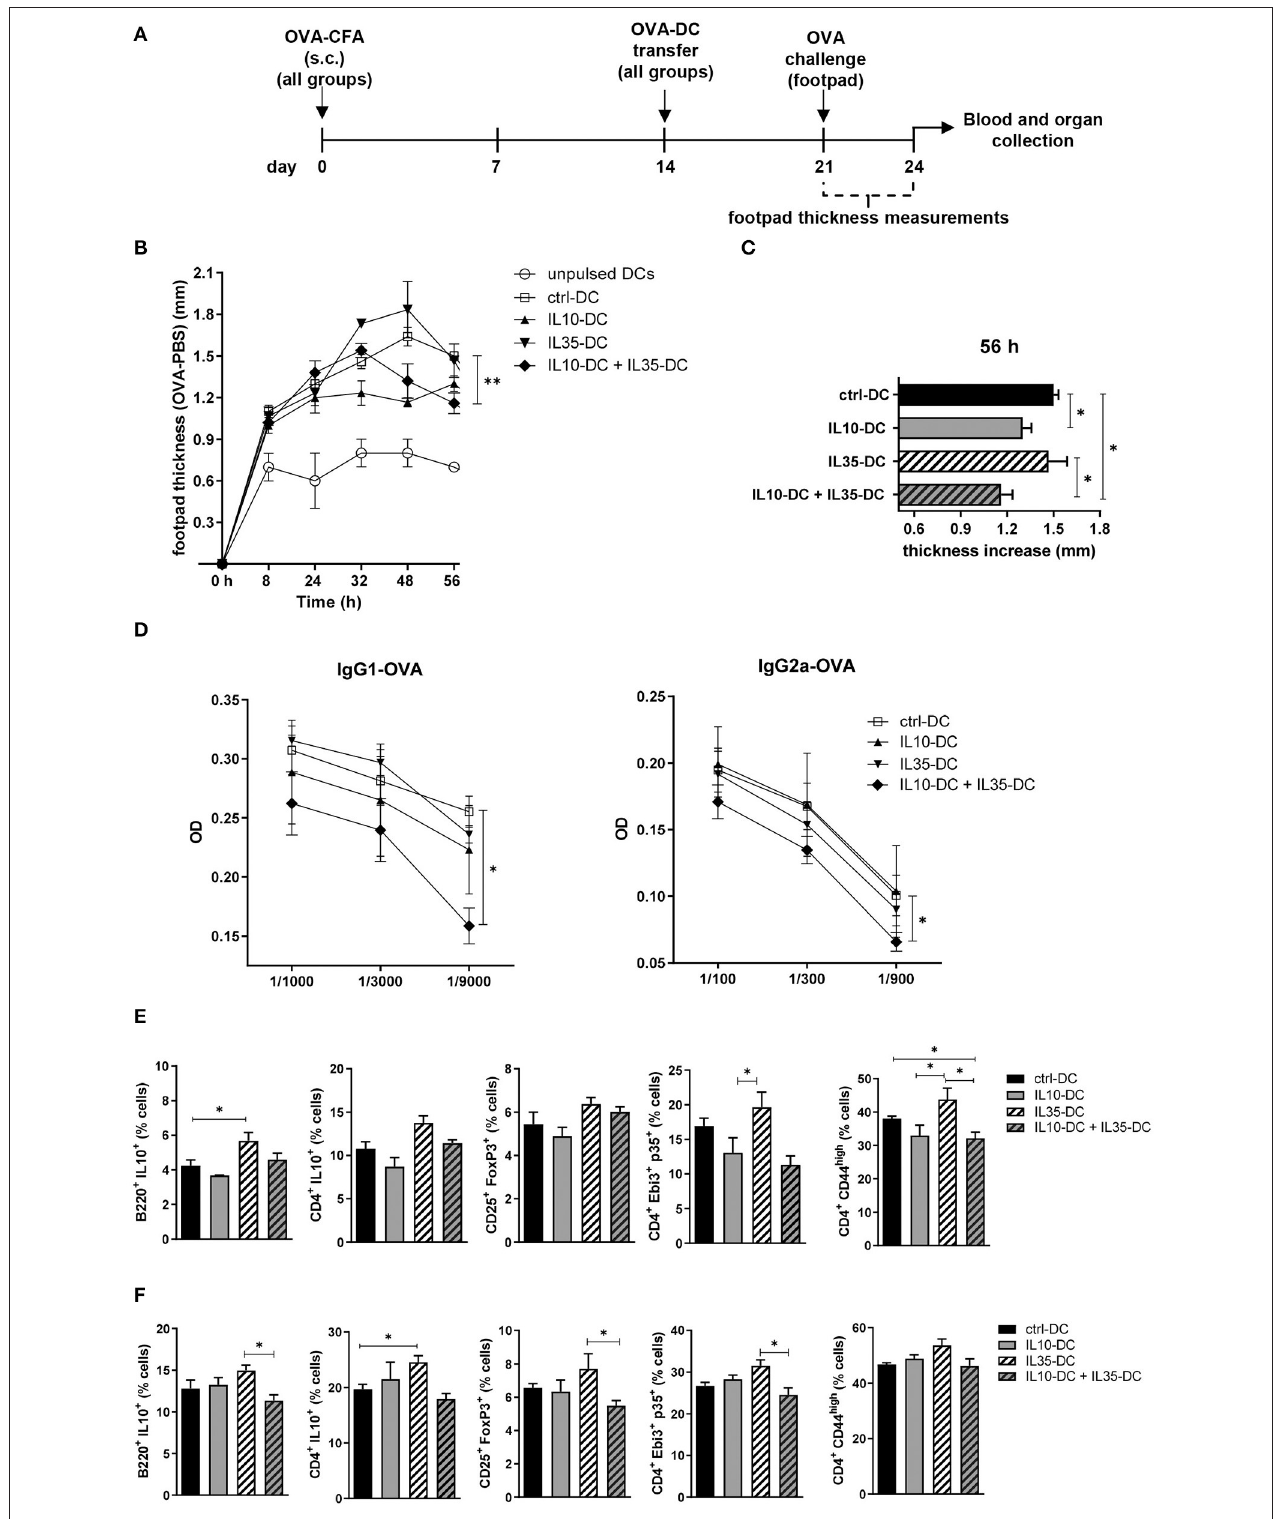
FIGURE 3 | The combination of IL10-DC and IL35-DC ameliorated in vivo inflammatory response. Mice were injected s.c. with 50 µ g of OVA in Complete Freund’s Adjuvant (OVA-CFA) at day 0 and divided in five different groups. At day 14, 3 × 10 6 OVA-pulsed DCs were injected (via i.p.) and 1 week later they were challenged with a heat-aggregated OVA (20 mg/mL) s.c. injection in the back-right footpad. Same volume of PBS (vehicle) was injected in the contralateral footpad as control.